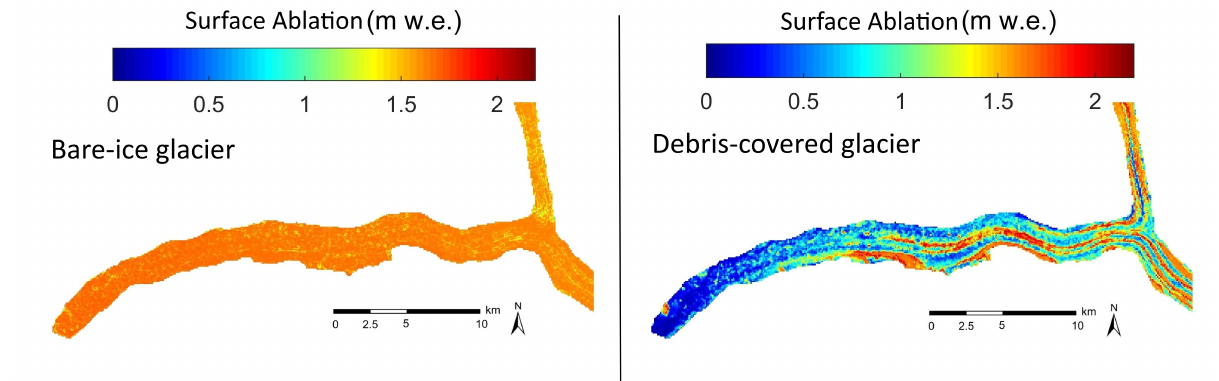
Figure 3. Comparison of simulated surface ablation from 1 June 2004 to 30 June 2004 for a hypothetical bare-ice scenario of the Baltoro Glacier, and the realistic debris-covered Baltoro Glacier. Note that the overall ablation for bare-ice scenario is higher, but the spatial heterogeneity in surface ablation is much higher on the debris-covered glacier. Other processes on debris-covered glaciers, such as supraglacial ponding may further elevate this differential surface ablation